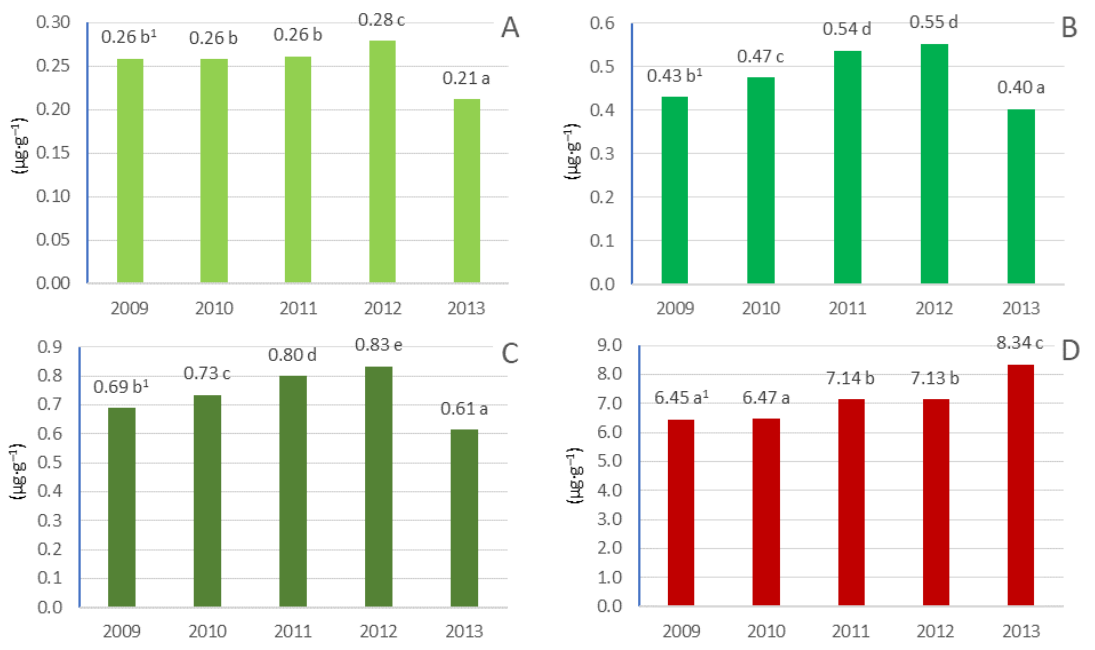
Figure 8. The content of chlorophyll pigments in the leaves depends on the year of research. ( A )—chlorophyll a, ( B )—chlorophyll b, ( C )—chlorophyll a + b, ( D )—carotenoids. 1 means that the same letters are not significantly different at α = 0.05 (Duncan’s test).